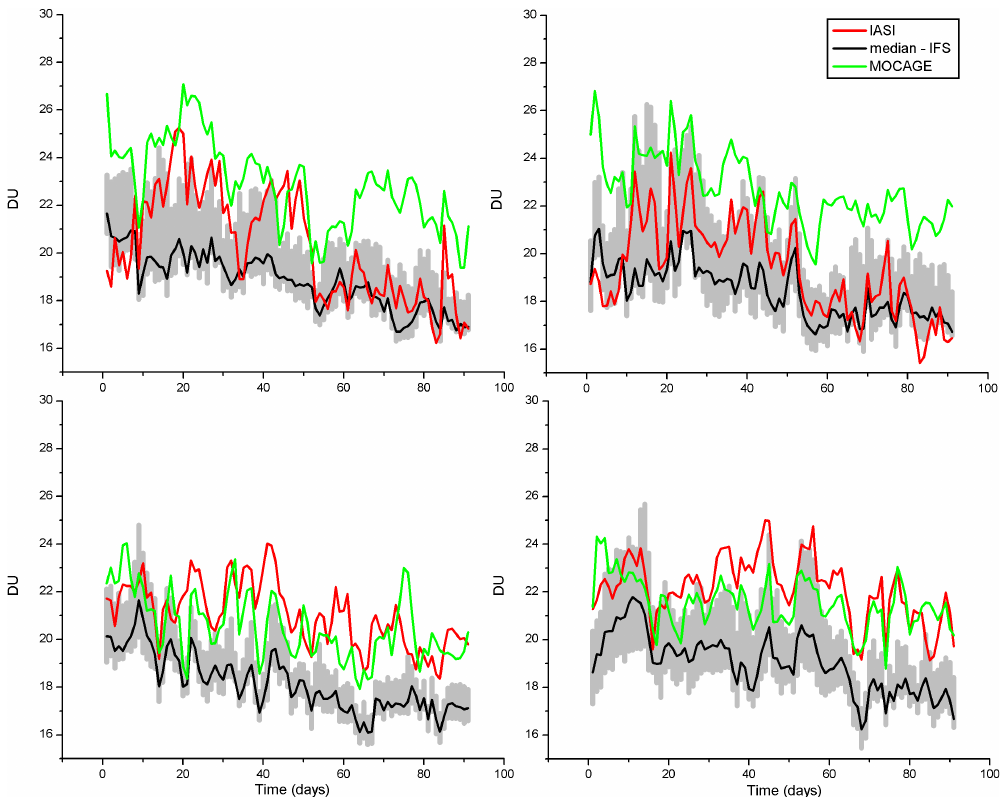
Fig. 7. Time evolution of 0–6km partial columns (in Dobson Unit) for IASI (red), the smoothed median model (black) and the MOCAGE model. The Max and Min of the ensemble are also plotted as error cloud around the median. In each case, daily values (i.e. value at about 10a.m.) are averaged over the considered geographical domain: North-Western Europe (upper left quarter of the model domain), South-Western Europe (bottom left), North-Eastern quarter of the domain (upper right), South-Eastern quarter of the domain (bottom